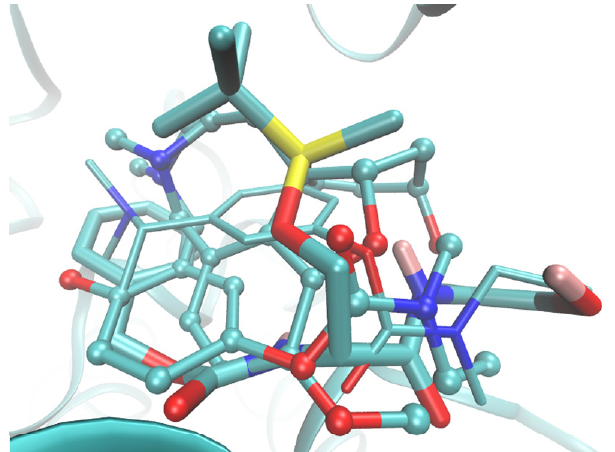
Figure 8. Active site of BChE enzyme (depicted as ribbons) bounded with GLT (displayed as balls and sticks), RIV (illustrated as thin sticks) and the most potent molecule 2 (presented as thick sticks).